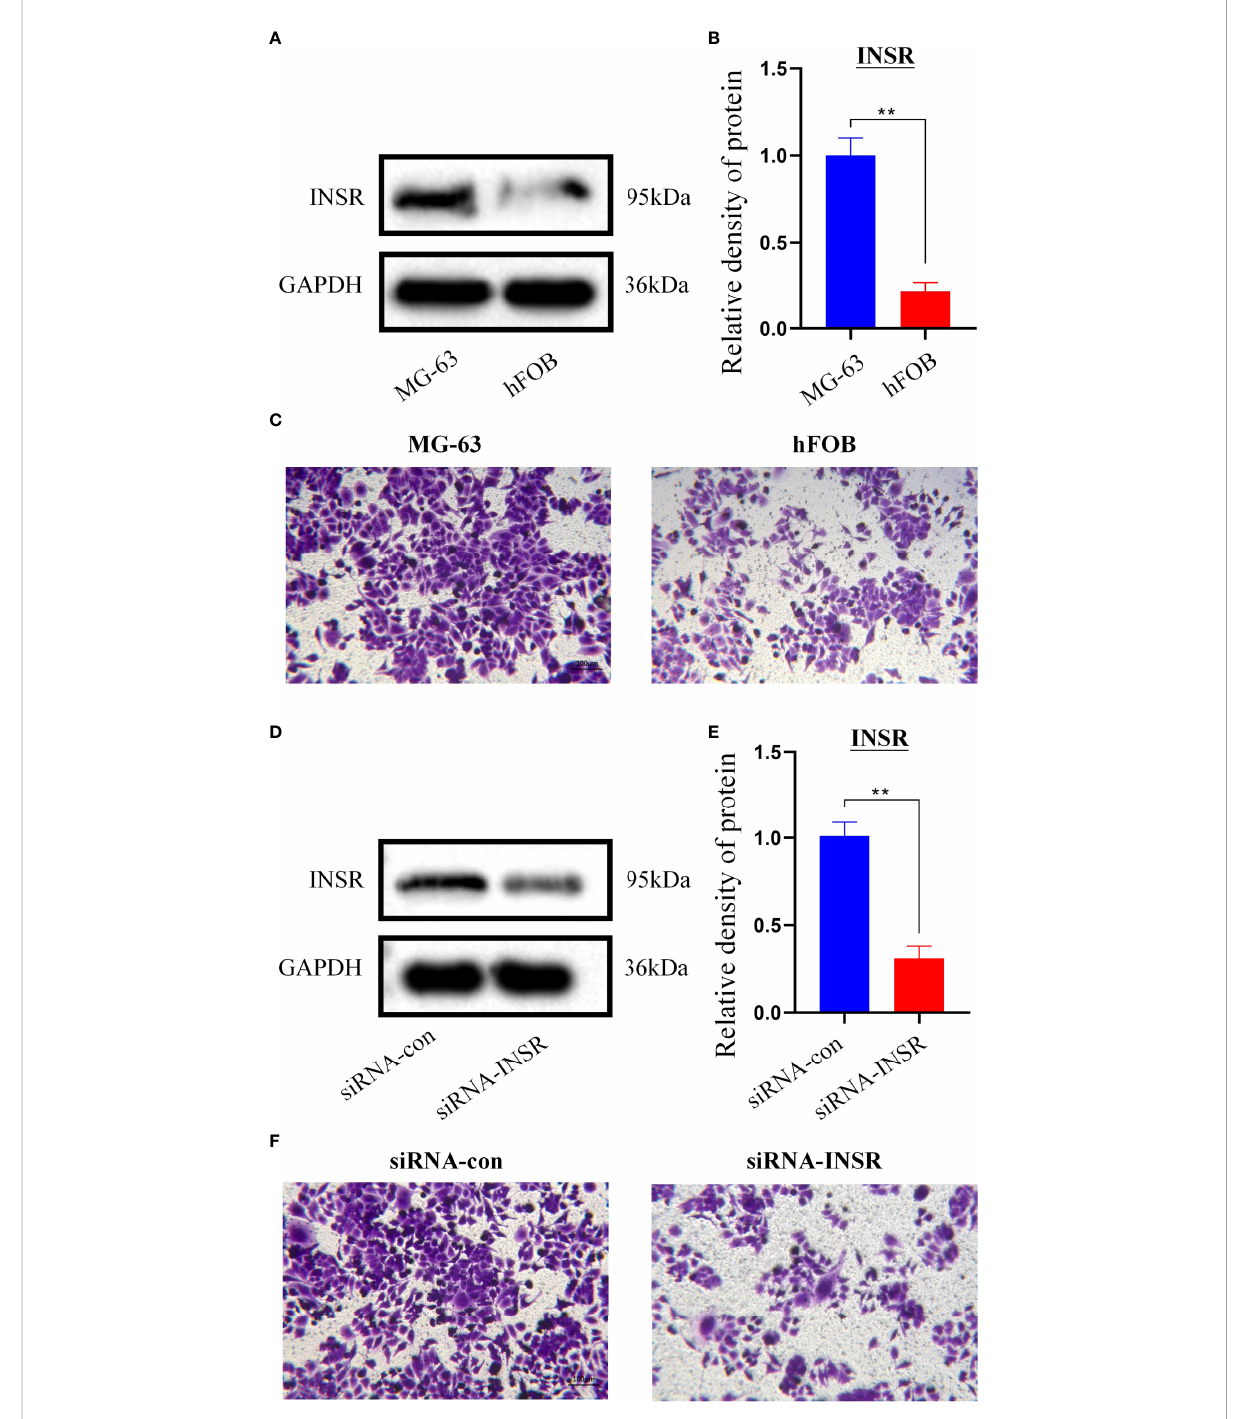
FIGURE 6 In vitro validation of INSR gene. (A) Expression of INSR protein by western blotting in MG-63 cells and hFOB 1.19 cells. (B) Relative density of INSR protein expression in MG-63 cells and hFOB 1.19 cells. n = 3, data are represented as mean ± SD, **P < 0.01 vs. MG-63 cells. (C) Transwell invasion of MG-63 cells and hFOB 1.19 cells. (D) Expression of INSR protein by western blotting in MG-63 cells after transfection of siRNA- control and siRNA-INSR. (E) Relative density of INSR protein expression in MG-63 cells after transfection of siRNA-control and siRNA-INSR. n = 3, data are represented as mean ± SD, **P < 0.01 vs. siRNA-control. (F) Transwell invasion of MG-63 cells after transfection of siRNA-control and